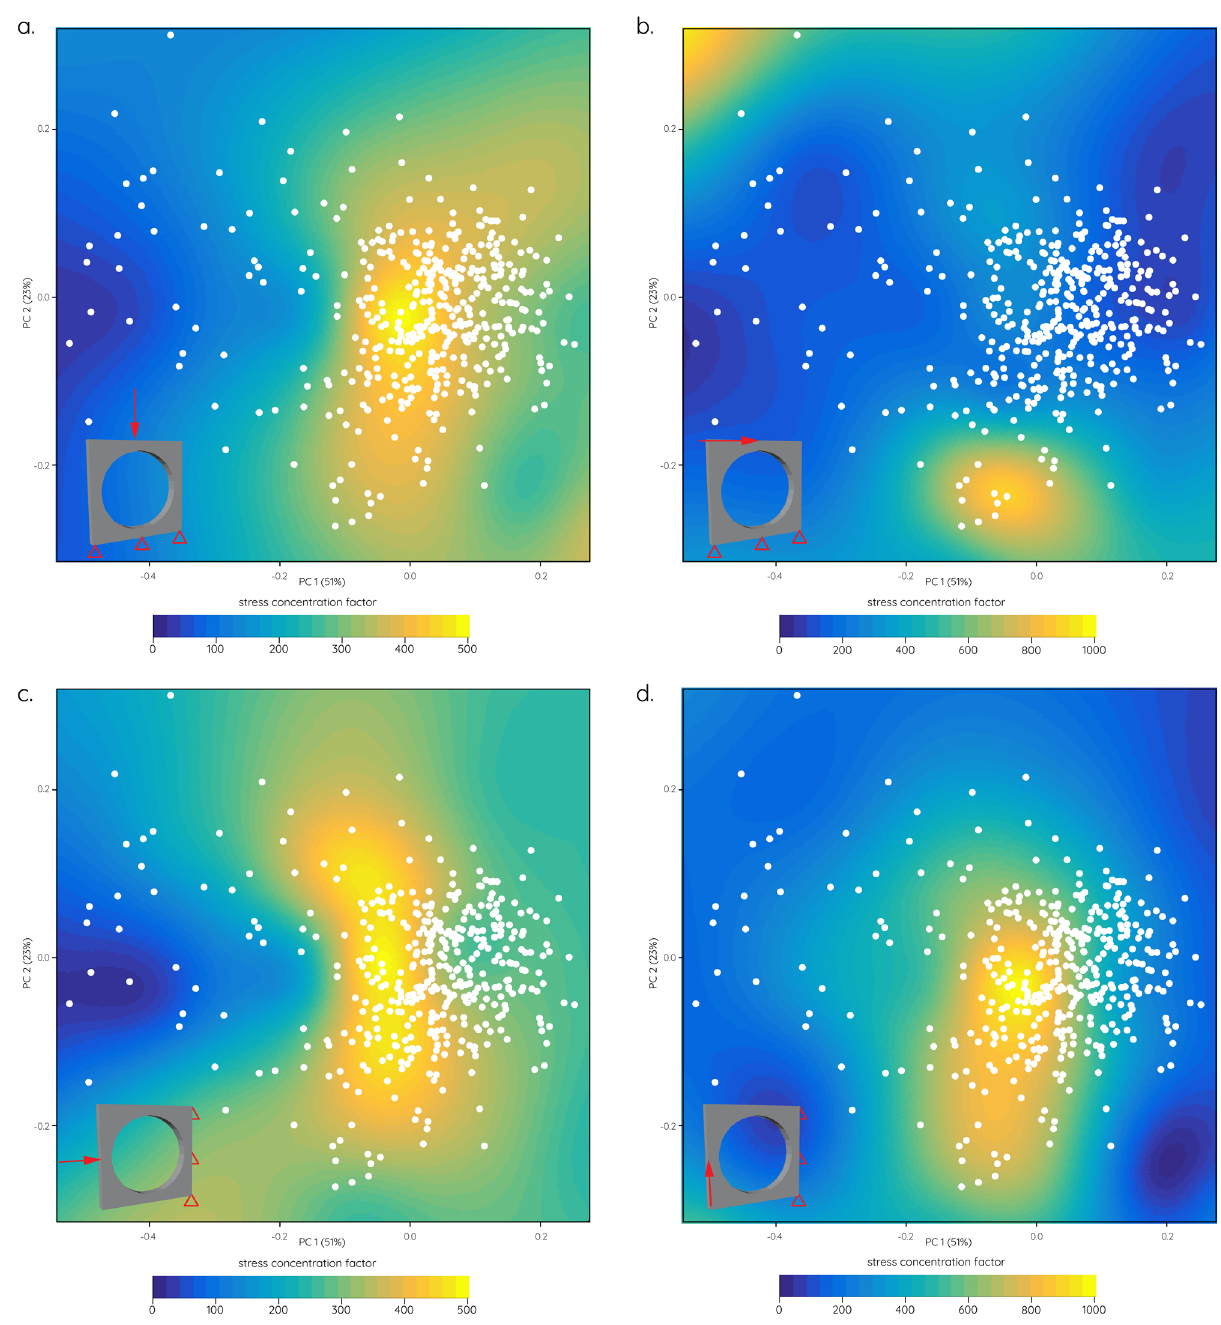
Fig. 6 Biomechanical performance spaces. Stress concentration factors (ratio between peak and reference stresses) for tested mechanistic planar models visualised as heatmaps with orbital shape morphospace superimposed. a Dorsoventral compression, b anterior shear, c anteroposterior compression, d dorsal